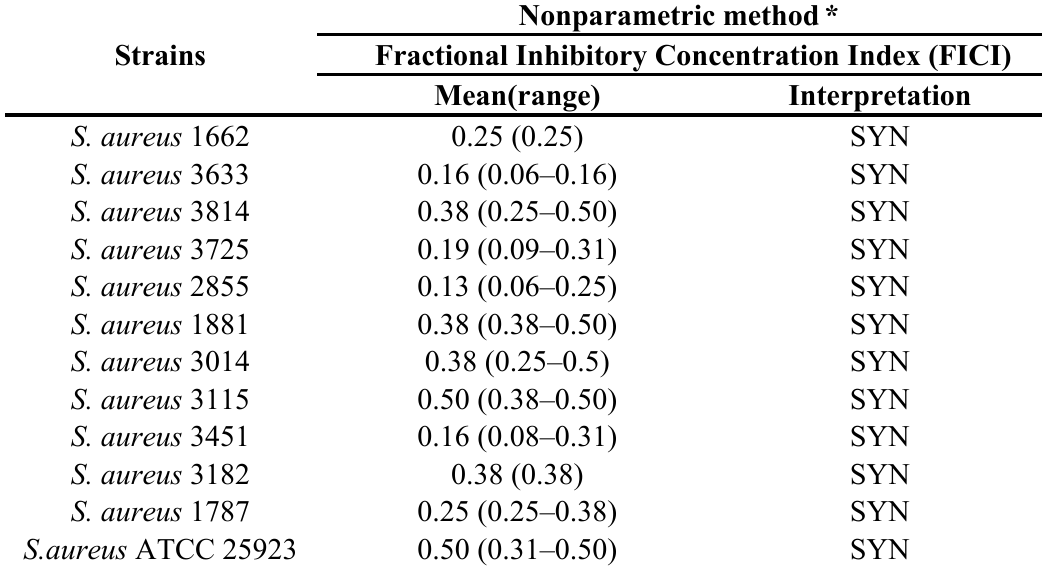
Table 2. In vitro interaction between CPFX and BCA.